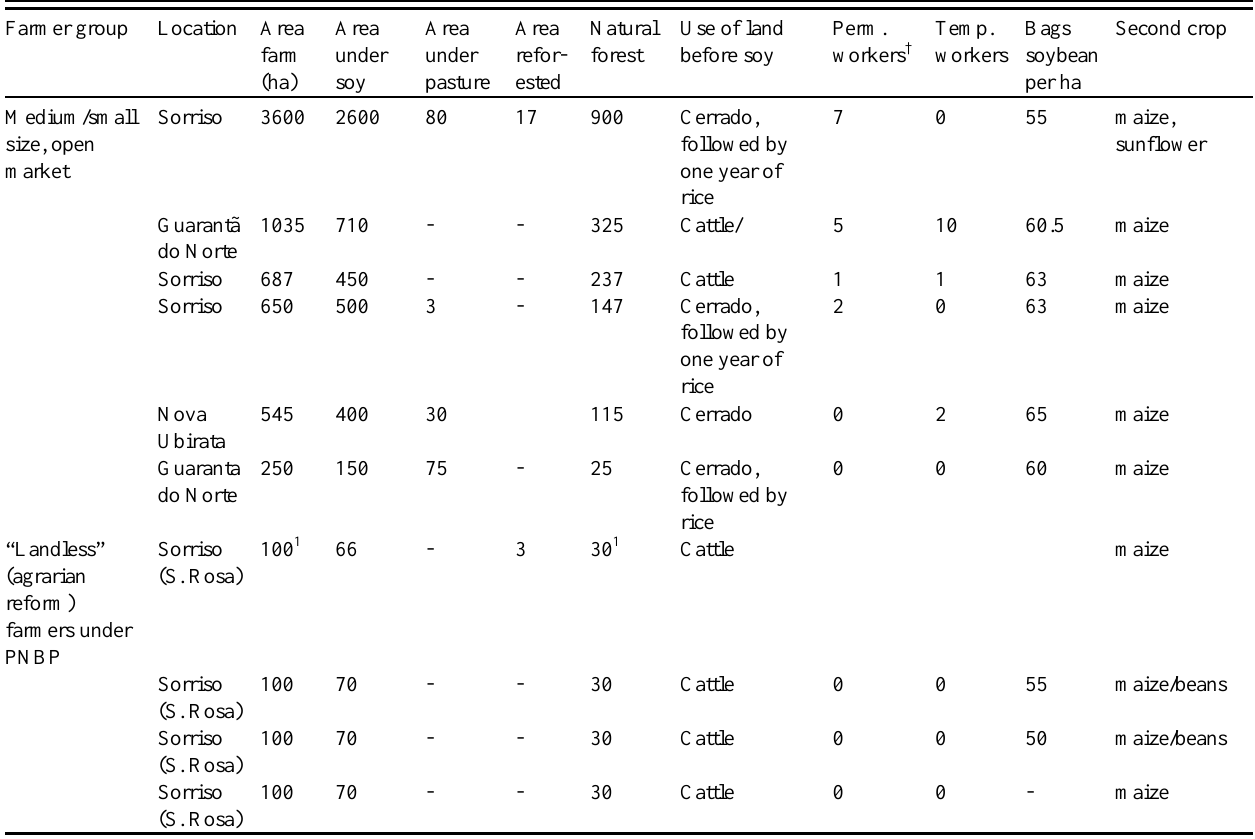
Table 2 . Characteristics of soy farms in the sample Farmer group Location